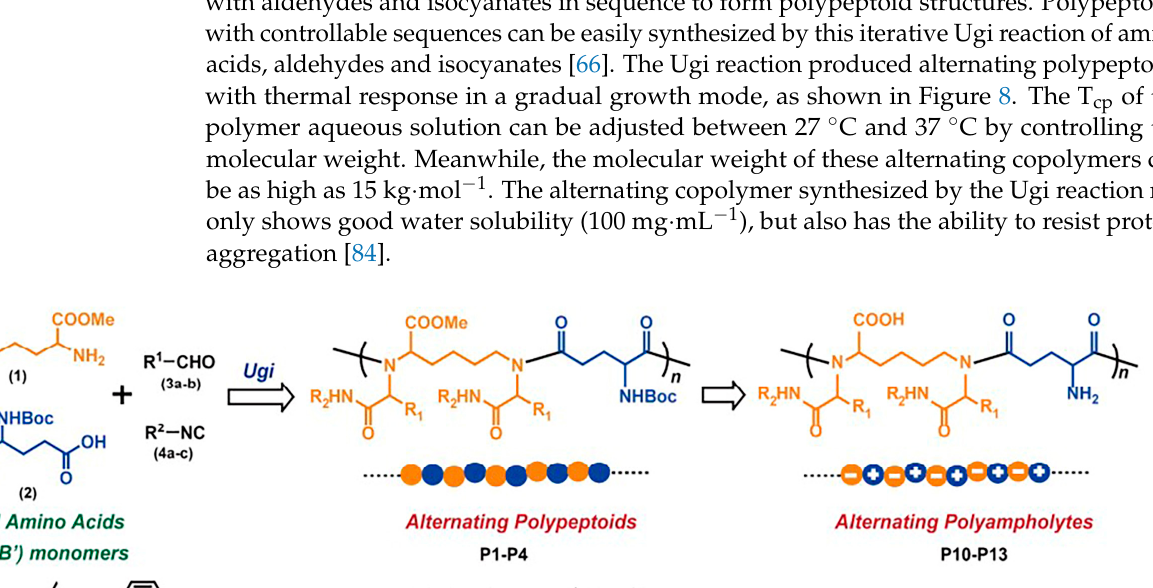
Figure 7. Synthesis of poly(N-propargyl glycine) and subsequent modifications of alkyne side chains. Reprinted with per- mission from [79] . Copyright 2015, Elsevier.